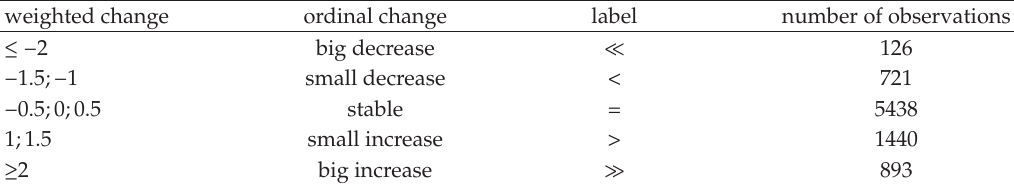
Table 11: Categorization of EDSS